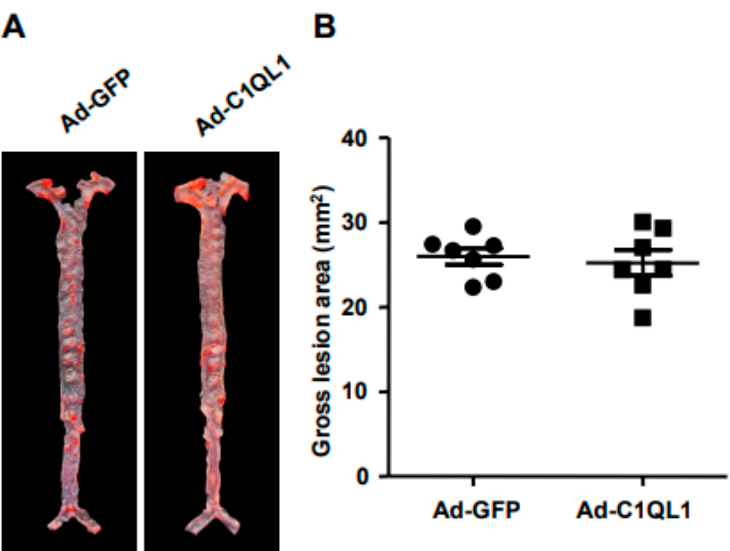
Figure 5. ( A ) Illustrative image of oil red O (ORO) staining in aortas. ( B )The absolute value of gross lesion area. For each cohort, data are presented as the mean ± SEM. n = 10 for each cohort.